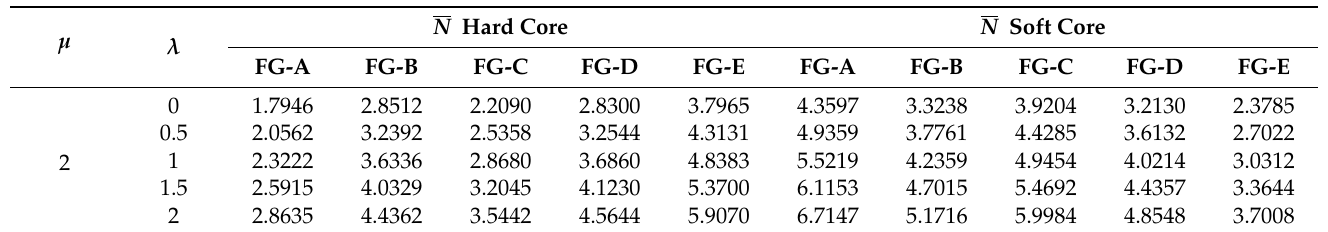
(cid:1) = 𝐺 = 𝐾 = 0) . 𝜁 𝜂 𝑤